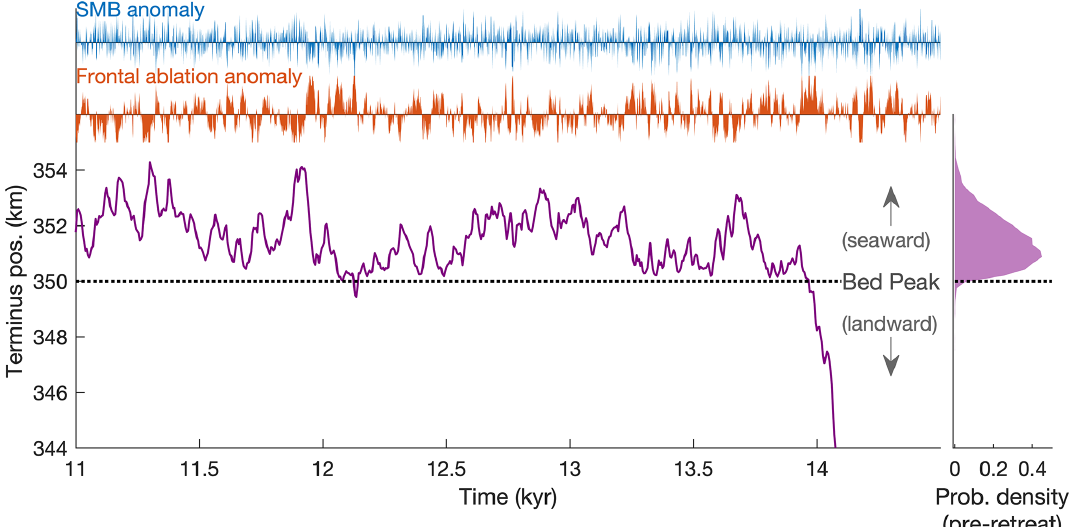
Figure 2. A synthetic glacier’s response to stochastic variability, when the terminus is near a peak in bed topography. Normalized climate anomalies are shown on the upper axes, and grounding-line fluctuations are below. Dashed line indicates the location of the bed peak. A long period of stable, stationary fluctuations precedes unstable retreat off of the bed peak. The histogram (right) shows the probability distribution of stable